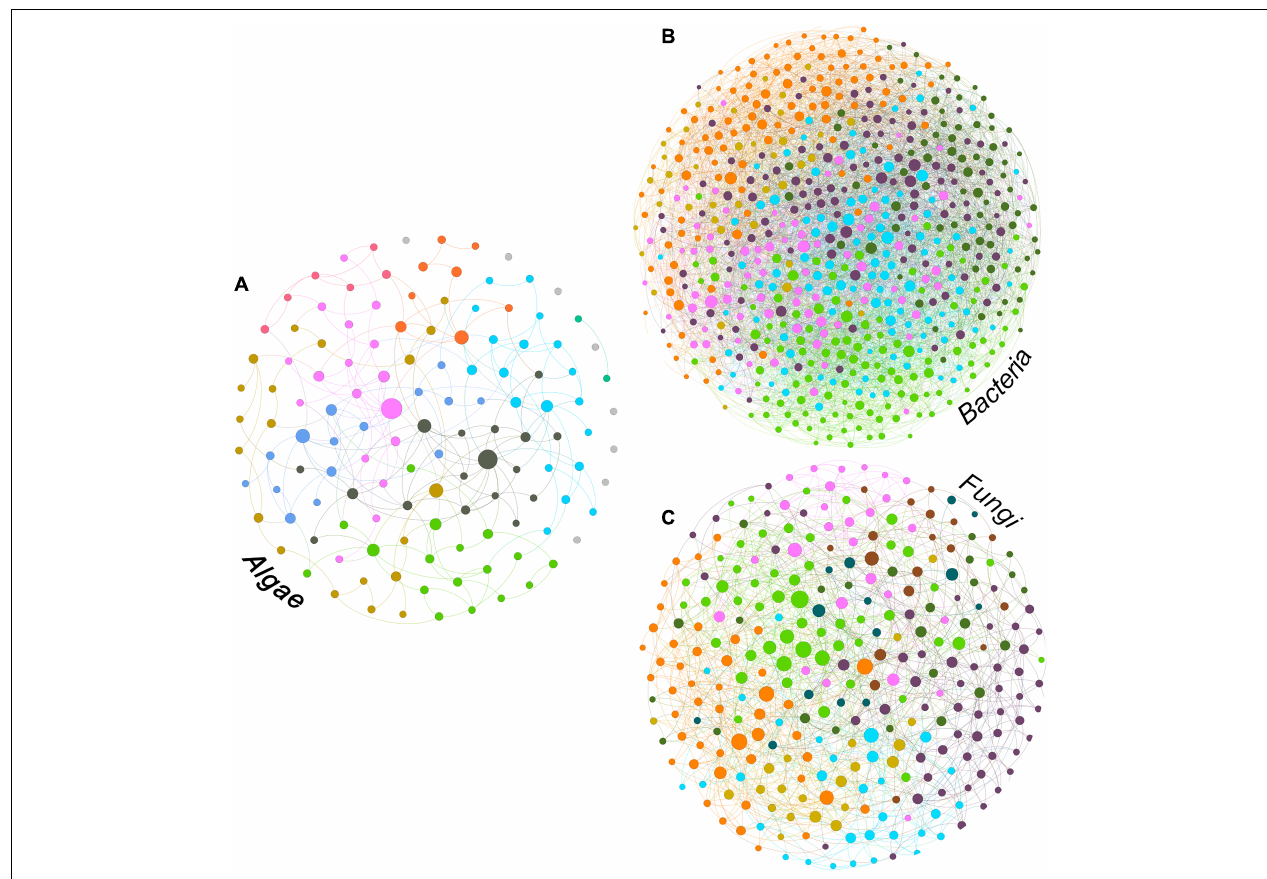
FIGURE 3 | Intra-group ASV interaction network for algal (A) , bacterial (B) and fungal (C) fractions of the bark microbiome. The size of the nodes is proportional to the value of betweenness centrality (based on Brandes (2001)) and colors correspond to modules (Blondel et al.,